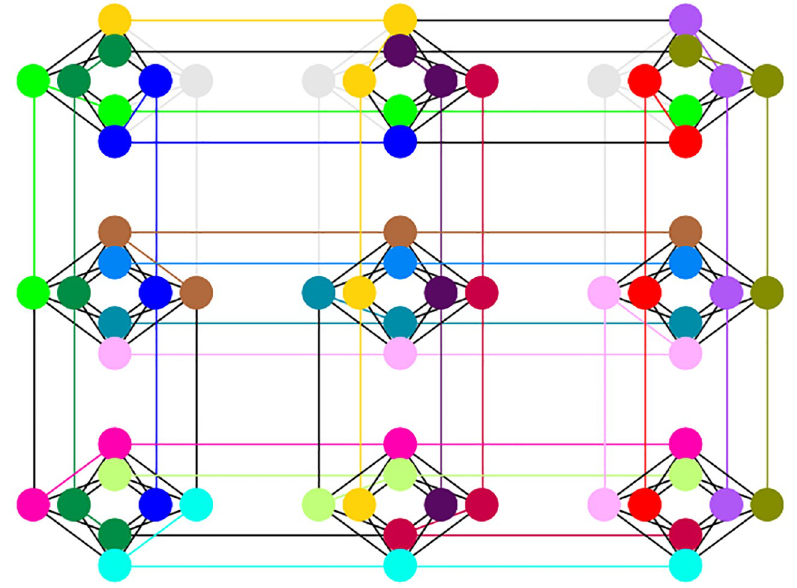
Fig 8. Embedding the QUBO in Chimera graph topology for the D-Wave quantum annealer. Each color represents one of the 16 logical qubits.